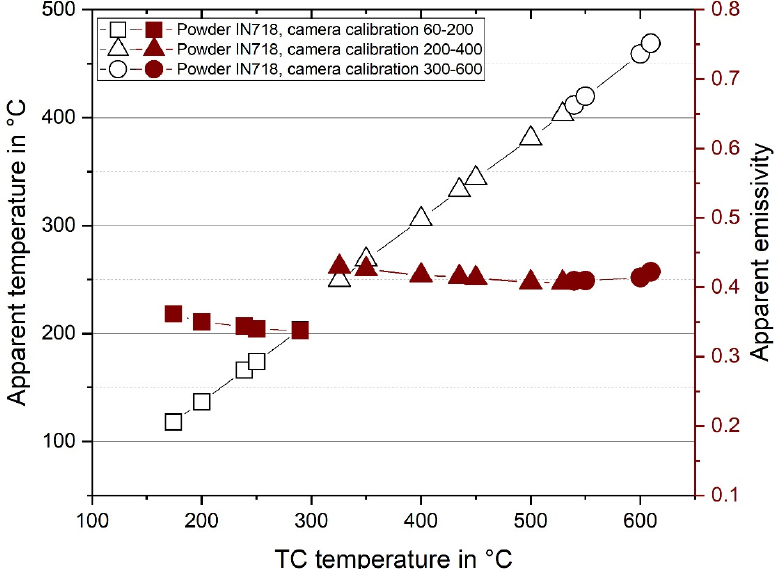
Figure 11. Apparent temperature (black hollow symbols) and apparent emissivity (brown full symbols) of IN718 powder layer over measured TC temperature.